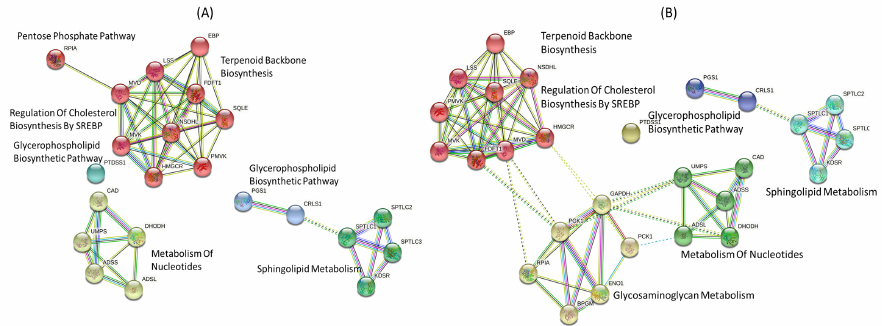
Figure 4. Protein-protein interactions. Protein-protein interactions of identified ( A ) one-target anticancer genes and ( B ) two-target combinations. MCL clustering in the STRING database was applied to classify one-target enzymes into four classes and two-target enzymes to five classes. The first class contained nine enzymes in terpenoid backbone biosynthesis, the second class included five enzymes in metabolism of nucleotides, the third class had four enzymes in sphingolipid metabolism, and the fourth class included two enzymes in glycerophospholipid biosynthetic pathway. For the one-target case, RPIA in the pentose phosphate pathway was categorized in the first class, but that in the two-target case was considered to participate in glycosaminoglycan metabolism or central carbon